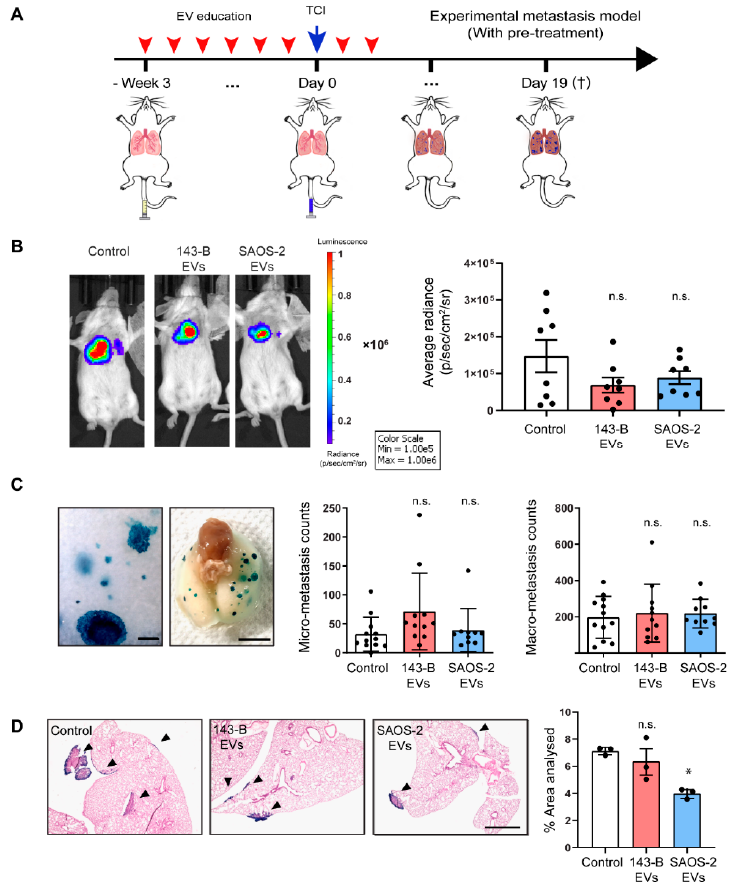
Figure 5. Pre-treatment with osteosarcoma-derived EVs does not affect 143-B experimental metastasis. ( A ) Scheme of the experimental setup. ( B ) Representative IVIS bioluminescence images of tumor cells 15 days after intravenous TCI (top panel) and respective quantification of bioluminescence (bottom panel). n = 8 mice for all groups. ( C ) Representative micrographic and macrographic images of 143-B experimental lung metastasis. Scale bars, 250 µm and 0.5 cm respectively. Quantification of X-gal stained micro-metastases (middle panel) and macro-metastases (right panel) on lung mounts of treated mice sacrificed 19 days after tumor cell injection; n = 12 mice for the control group, n = 11 mice for the 143-B group, n = 10 for the SaOS-2 group. ( D ) Representative images of OCT-embedded lung tissue stained for X-gal and H&E from the indicated groups (left panel). Scale bar, 1 mm. Quantification of tumor tissue area (right panel); n = 3 mice for all groups. (n.s., nonsignificant; *, p < 0.05, Bonferroni’s one-way ANOVA test). Additionally, in a complementary approach investigating EV effects on the total metastatic load, we determined the total metastatic area covered by all metastatic nodules through histological examination of lung sections in a subset of mice (Figure 5D). In line with our in vivo observations, H&E staining revealed similar metastatic areas in the control and 143-B experimental groups. Interestingly, we observed a decrease in metastatic area in SAOS-2 EV treated mice. This observation is supported by a previous study that reports decreased metastases when pre-treated with EVs isolated from non-metastatic melanoma cells, however, we only report a decrease in metastatic area and not the number of metastases [28]. In summary, we establish that both 143-B and SAOS-2 cell- derived EV education do not affect metastases formation in an experimental metastasis model in SCID mice.